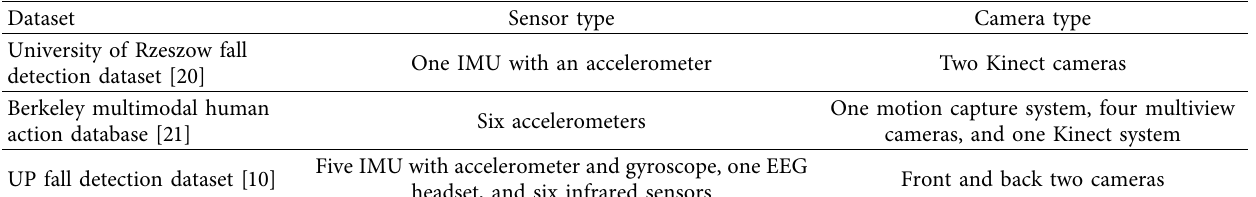
Table 1: Different multimodal fall detection